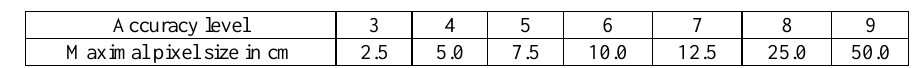
Table3: Ground Sample Distance for digital images (used in mapping and for ortho